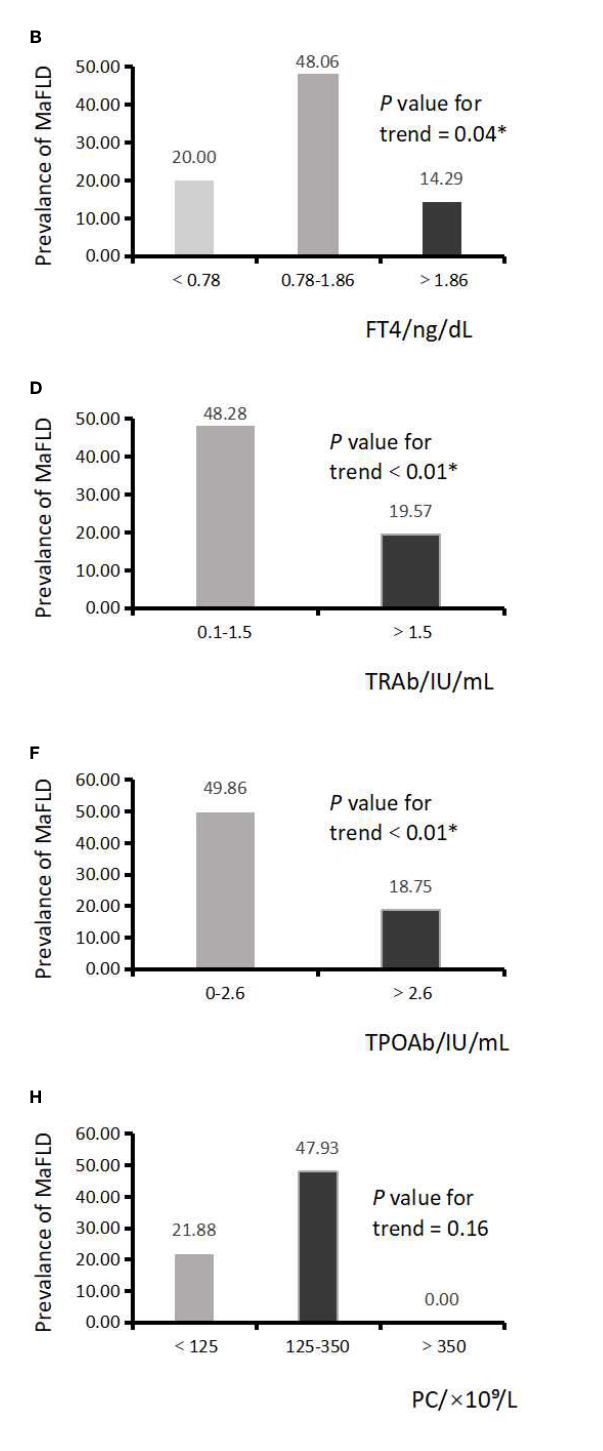
FIGURE 2 | Serum thyroid hormones, thyroid autoantibodies, in fl ammatory biomarkers, and the proportions of metabolic dysfunction associated fatty liver disease (MAFLD) patients. (A) Serum thyroid stimulating hormone (TSH) level and the proportion of MAFLD patients. P trend < 0.01*; (B) Serum FT4 level and the proportion of MAFLD patients. P trend = 0.04*; (C) Serum FT3 level and the proportion of MAFLD patients. P trend = 0.42; (D) Serum TRAb level and the proportion of MAFLD patients. P trend < 0.01*; (E) Serum TgAb level and the proportion of MAFLD patients. P trend < 0.01*; (F) Serum TPOAb level and the proportion of MAFLD patients. P trend < 0.01*; (G) Serum hsCRP level and the proportion of MAFLD patients. P trend < 0.01*; (H) PC and the proportion of MAFLD patients. P trend =